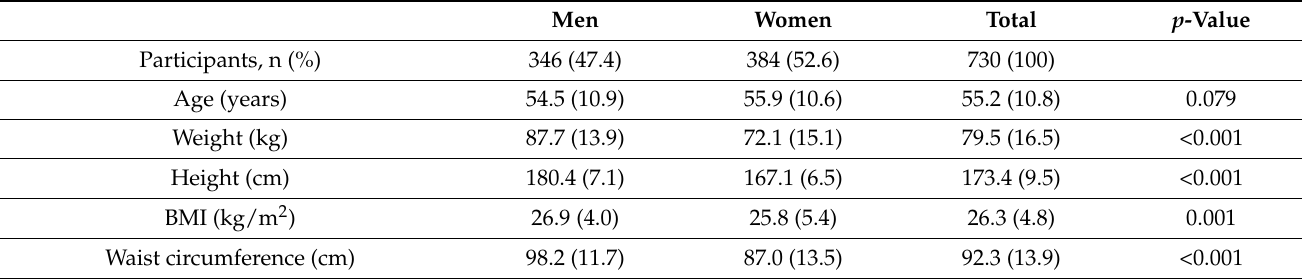
Table 1. Participants’